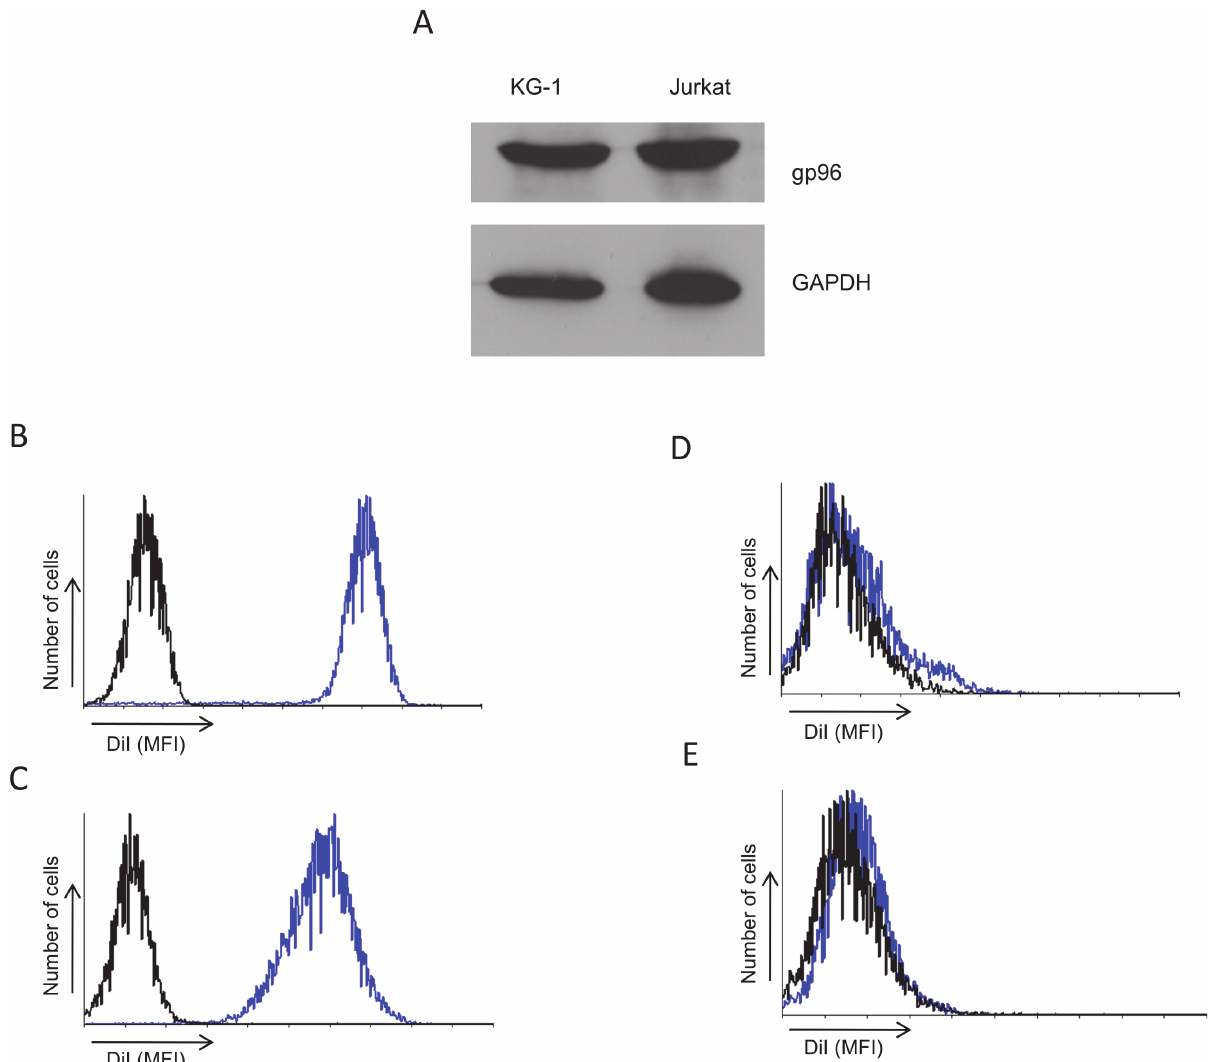
Fig 4. KG-1 cells express gp96 and can functionally take up LDL. (A) Immunoblots of KG-1 and Jurkat cell lysates using gp96 and GAPDH antibodies. (B) Jurkat and (C) KG-1 cells were incubated with DiI-LDL for 4 hours treated with trypsin and fluorescent cells were detected using fluorescence